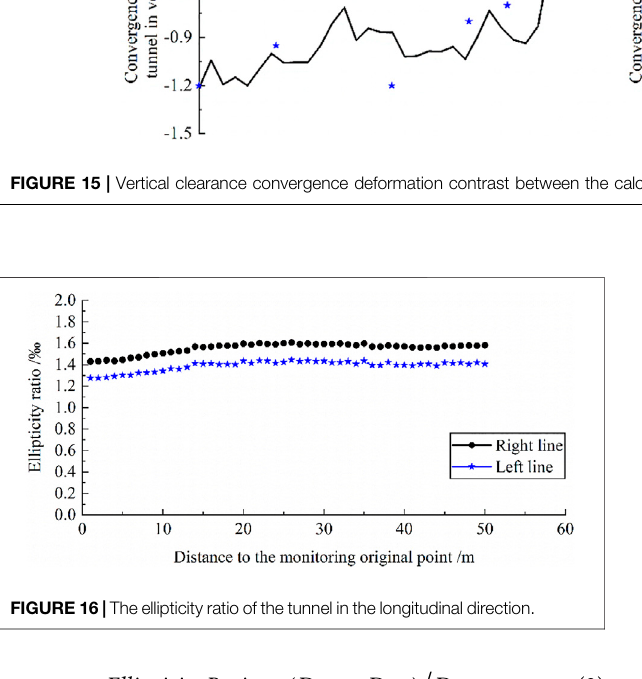
Frontiers in Earth Science |